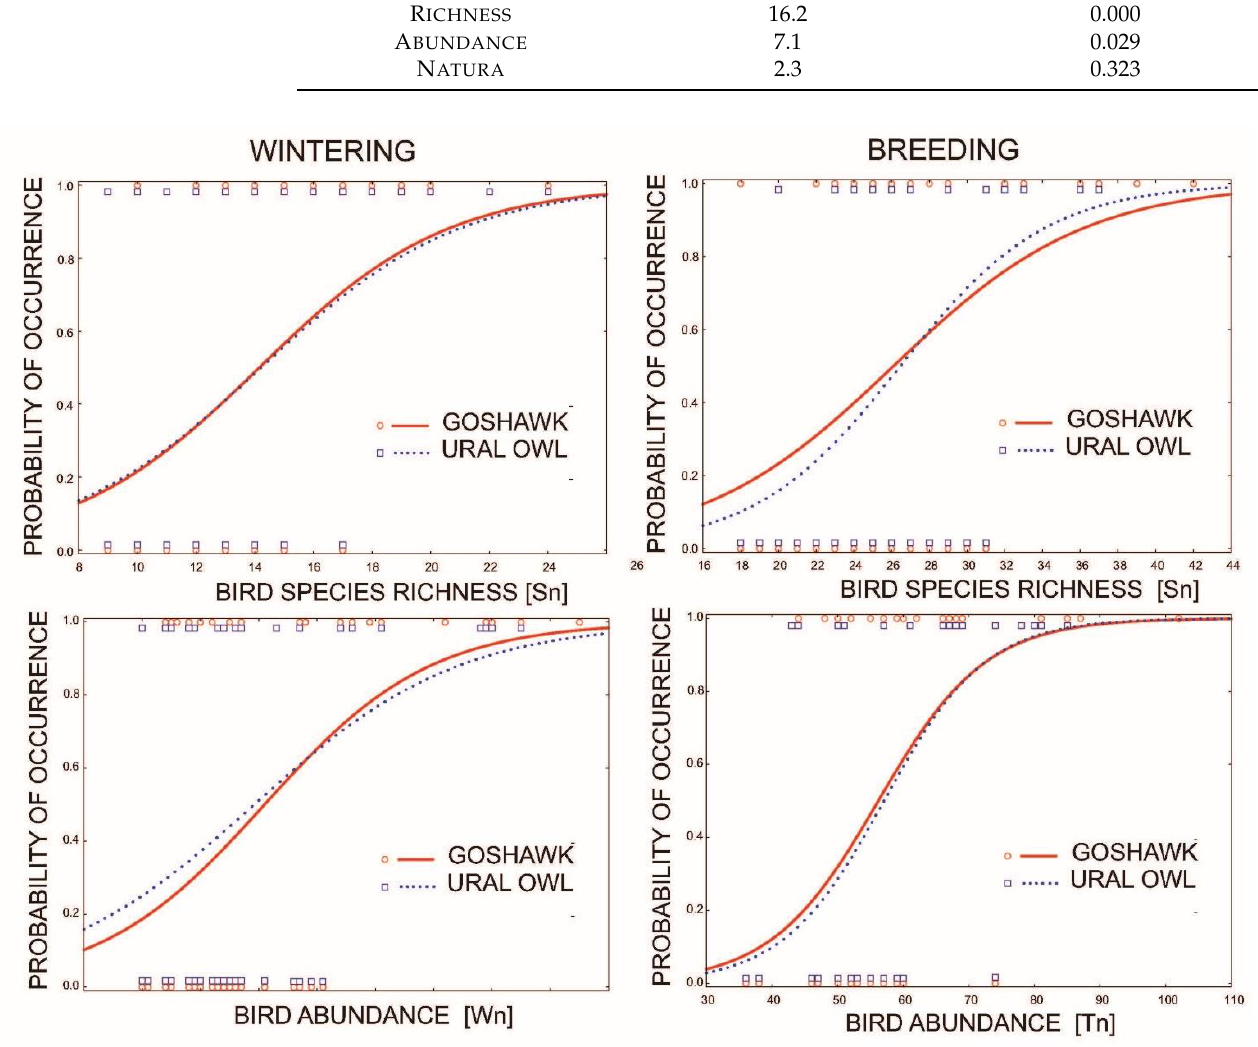
Figure 2. Linear regression curves showing dependencies between occurrence of long-lasting territo- ries of goshawks or Ural owls (0—absence, 1—100% certain occurrence) and bird species RICHNESS and ABUNDANCE (both measured for wintering and breeding periods). sN—number of species, wN—number of wintering individuals, tN—number of territorial